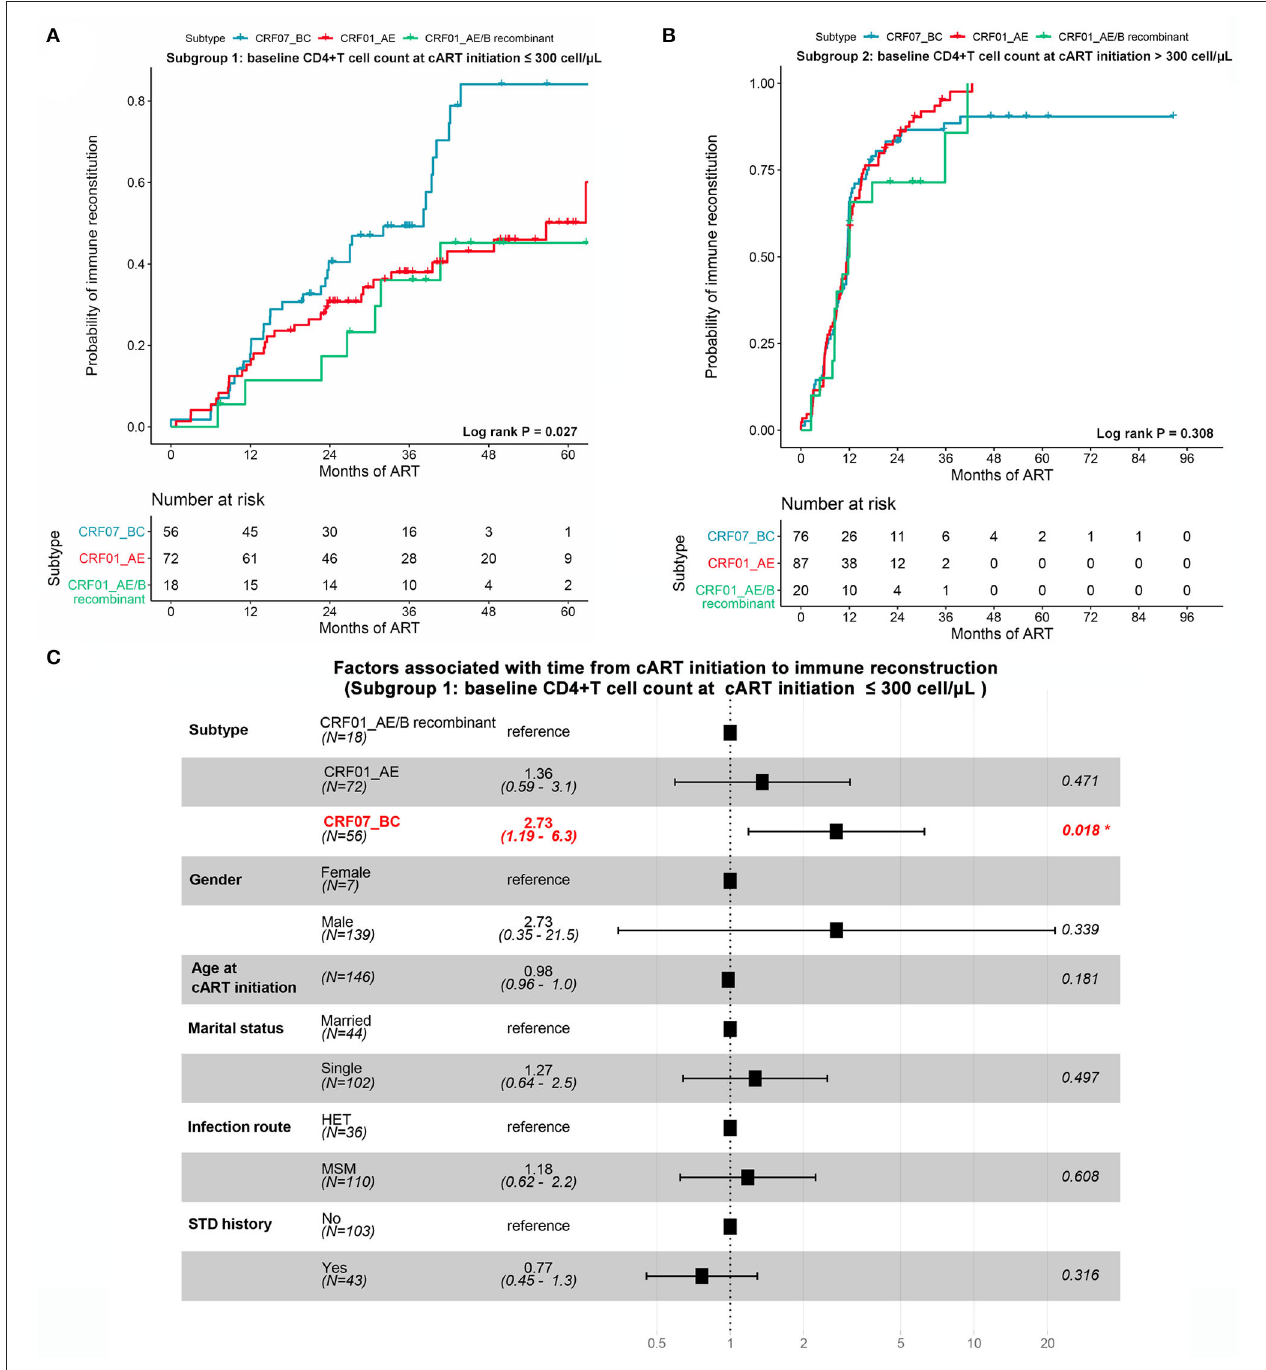
FIGURE 5 | The impact of CRF01_AE/B recombinants on immune reconstruction after cART. (A,B) The possibility of achieving immune reconstruction (from cART initiation to CD4 + cell count > 500 cells/ µ l) among different HIV-1 subtypes stratified by baseline CD4 + T-cell count at cART initiation. (A) Patients with CD4 + T-cell count at cART initiation ≤ 300 cells/ µ l. (B) Patients with CD4 + T-cell count at cART initiation > 300 cells/ µ l. The statistical difference was examined using the log-rank test. (C) The forest plot showing the factors associated with immune reconstruction at subgroup of patients with CD4 + T-cell count ≤ 300 cells/ µ l. Patients with CRF01_AE/B recombinants were less likely to reach a normal CD4 + T-cell count than CRF07_BC patients but not different from CRF_01AE patients.